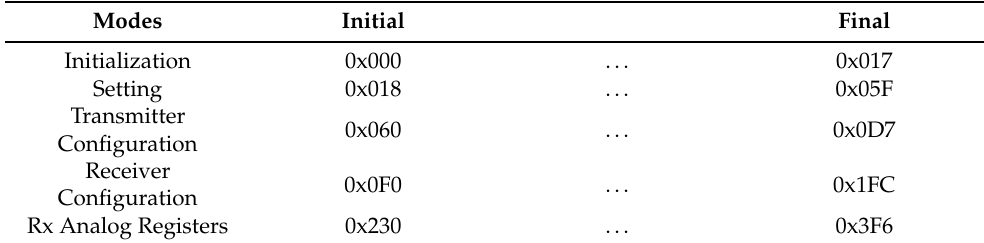
Table 2. Functions of the AD9364 registers.